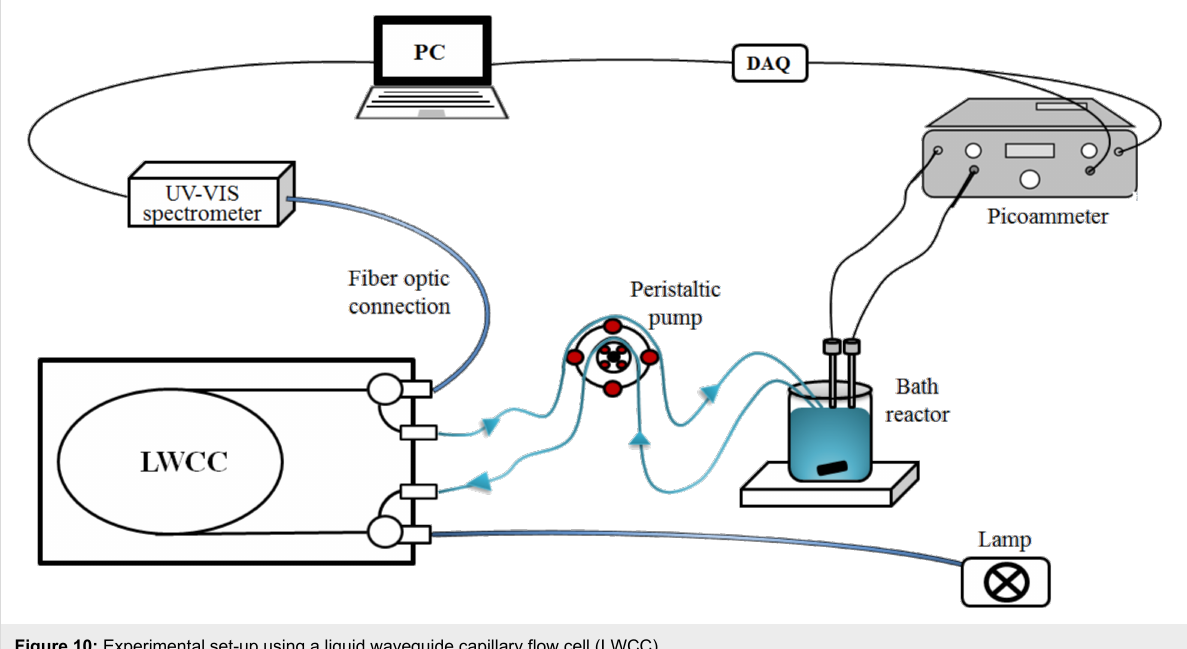
with a Waters 996 Photodiode Array Detector; UV–vis detec- tion), using a C8 column (Waters Symmetry: 150 × 4.6 mm, 3.5 μ m). The mobile phases were 0.1% aq phosphoric acid (A), and acetonitrile (B), run in a linear gradient (80:20, v/v) at a flow rate of 1